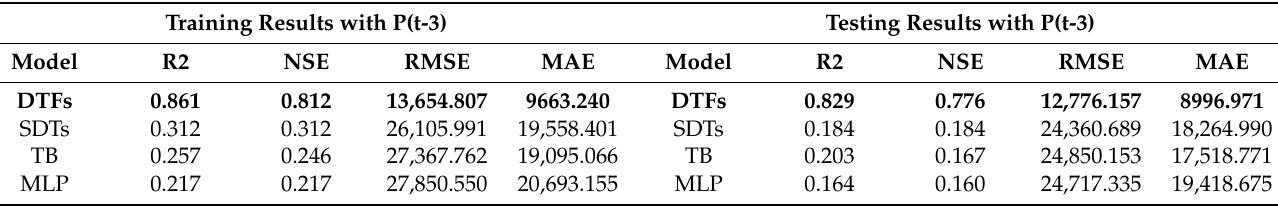
Table 6. Training and testing results with Q(t-3) of different data mining